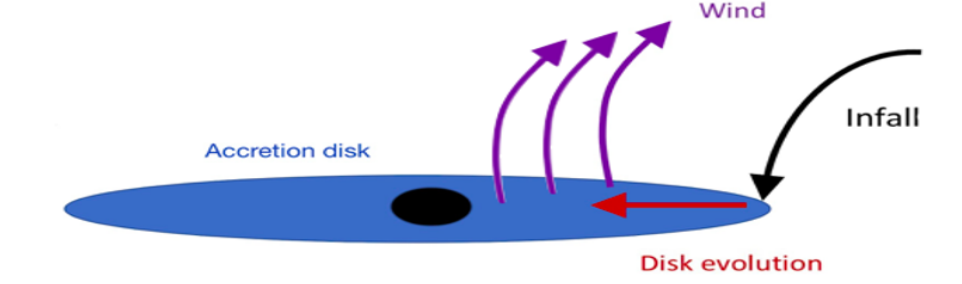
Figure 1. Schematic view of the path followed by material entering neutron star accretion